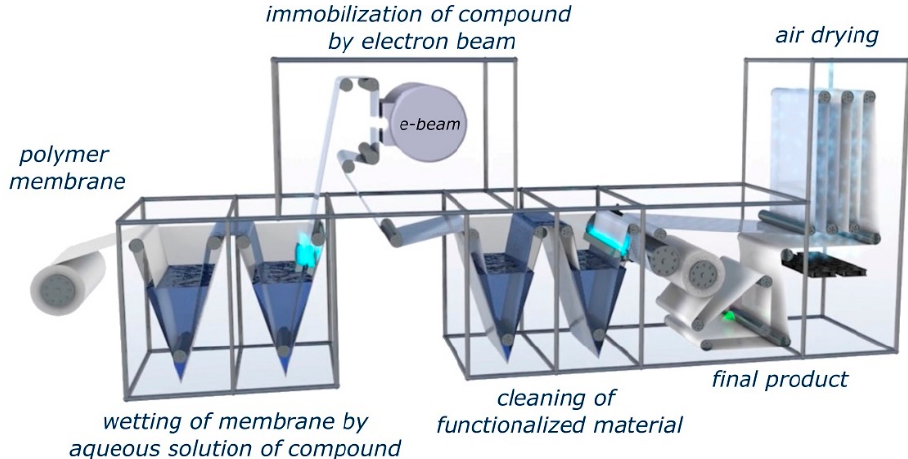
Figure 2. Illustration of our platform technology for roll-to-roll processing of polymer membranes at the Leibniz Institute of Surface Engineering (IOM).